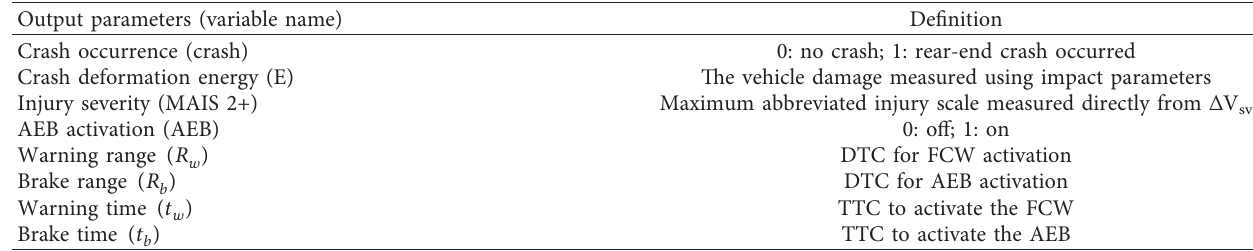
Table 5: Output parameters measured from the